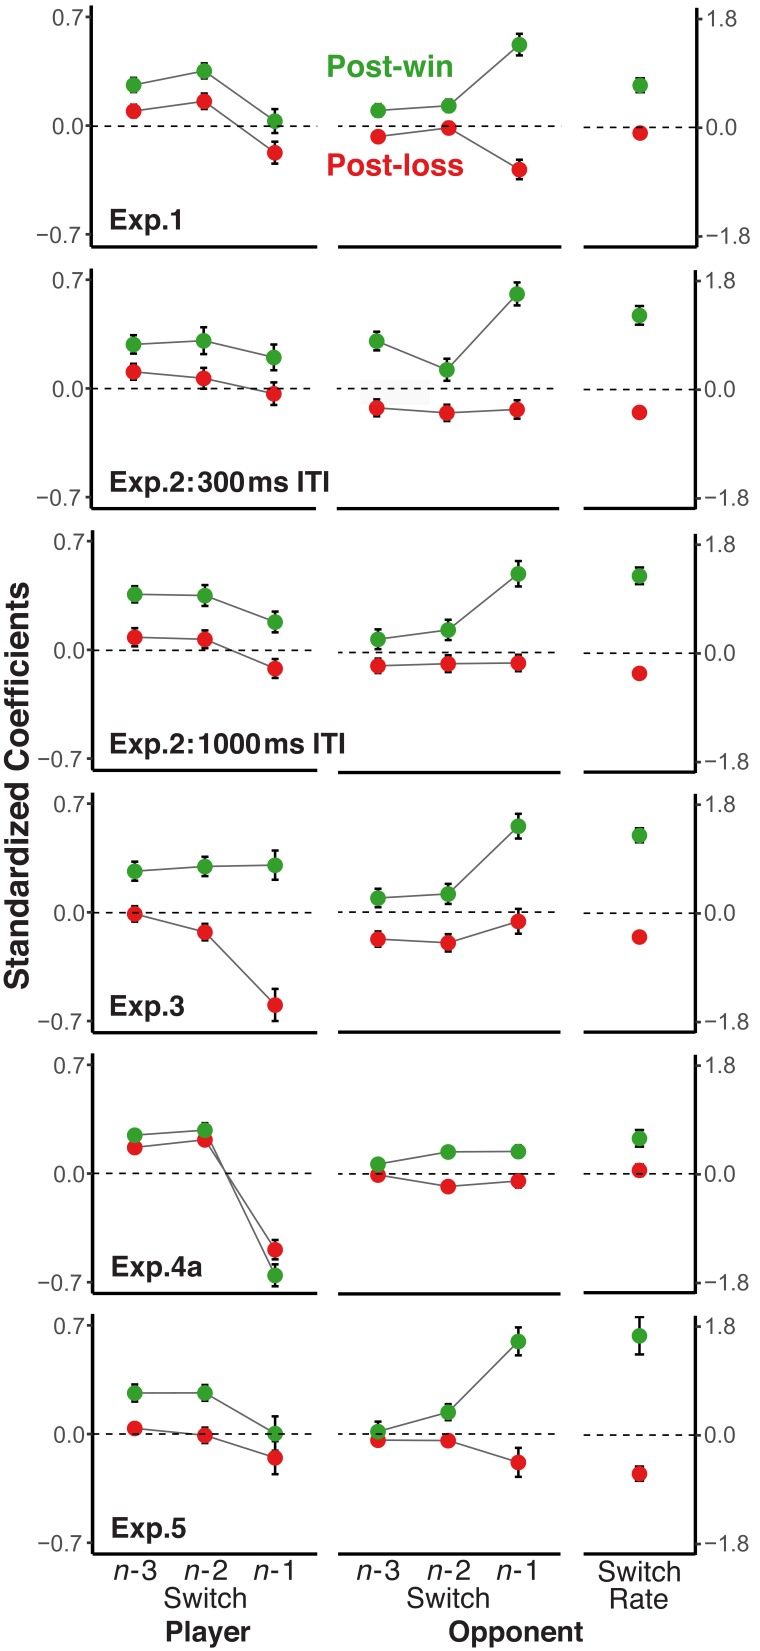
History analysis with signed action choices.Our main analyses to test the win/loss difference in the strength of the relationships between history/context and current choices involved selectively reversing labels of some of the predictors (see Figure 4). This figure supplement shows the, original, signed coefficients. For the opponent-related predictors, coefficients were generally positive following win feedback and negative, albeit smaller in size, following loss feedback. For player-related effects, the strength of the effects was also stronger following win than following loss trials, but the signs of the coefficients were less consistent than for the opponent-related predictors. Generally, these results are consistent with the conclusion that loss-feedback dampens the influence of the recent task context in general, not just as it relates to the opponents’ overall strategy.